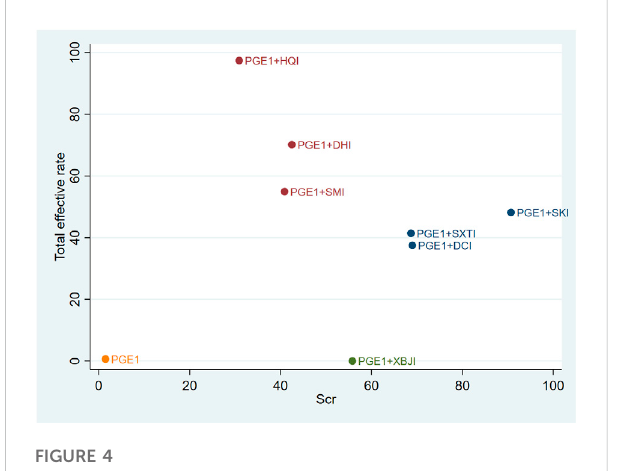
FIGURE 6 Clustering diagram of 24h Alb and